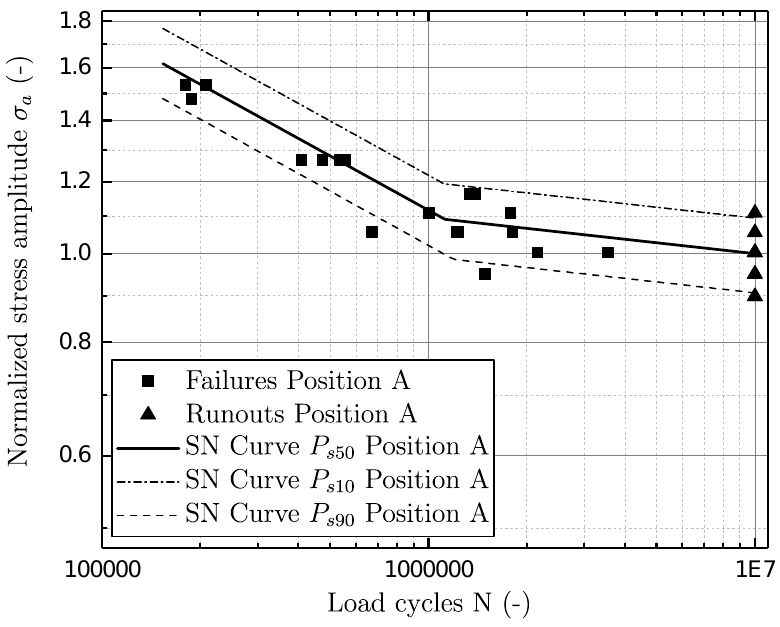
Figure 5. S–N curve for position A.